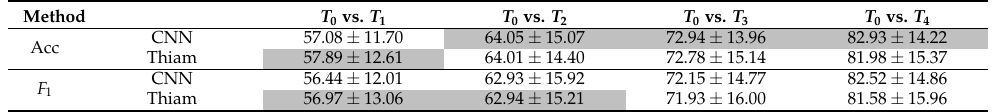
Table A1. 5 × LOSO average performance using the EDA sensor of the BVDB for the Thiam and CNN architectures. Performance metrics are given as average accuracy (upper) and F 1 score (lower half) ± average standard deviation of each individual LOSO run. Moreover, the best performing approach is highlighted in